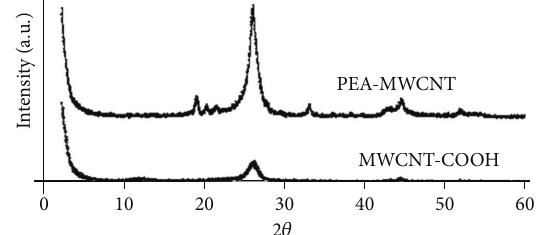
Figure 9: XRD diffractions of MWCNT-COOH, PEA-MWCNT.